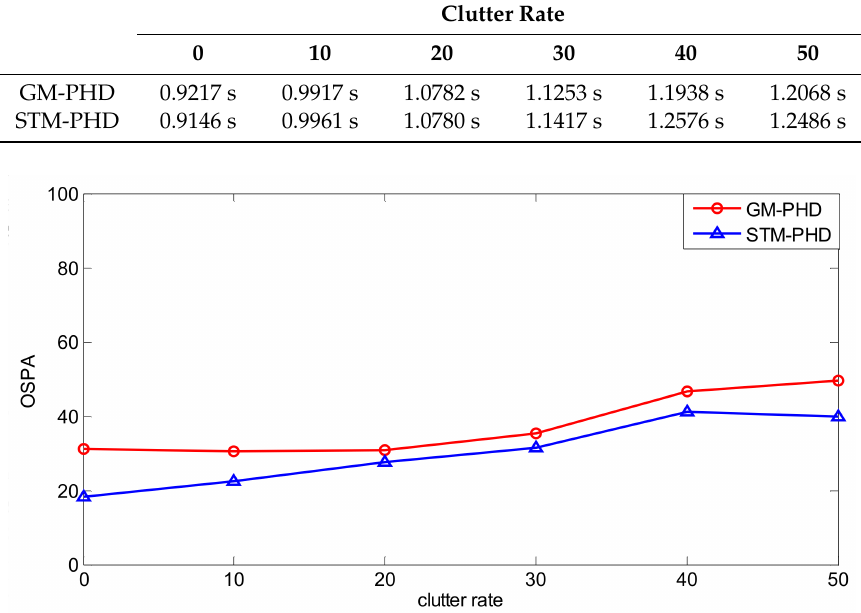
Figure 7. Comparison of OSPA distance for two filters with different clutter